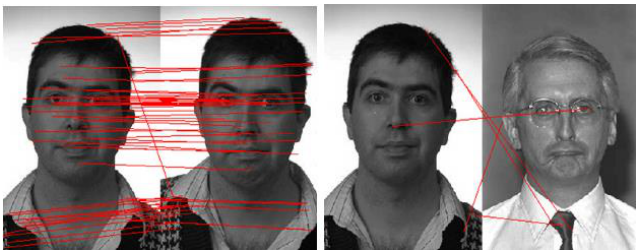
Figure 7. Face recognition based on the speeded-up robust features (SURF) descriptor [58]: recognition using fast library for approximate nearest neighbors (FLANN) distance.